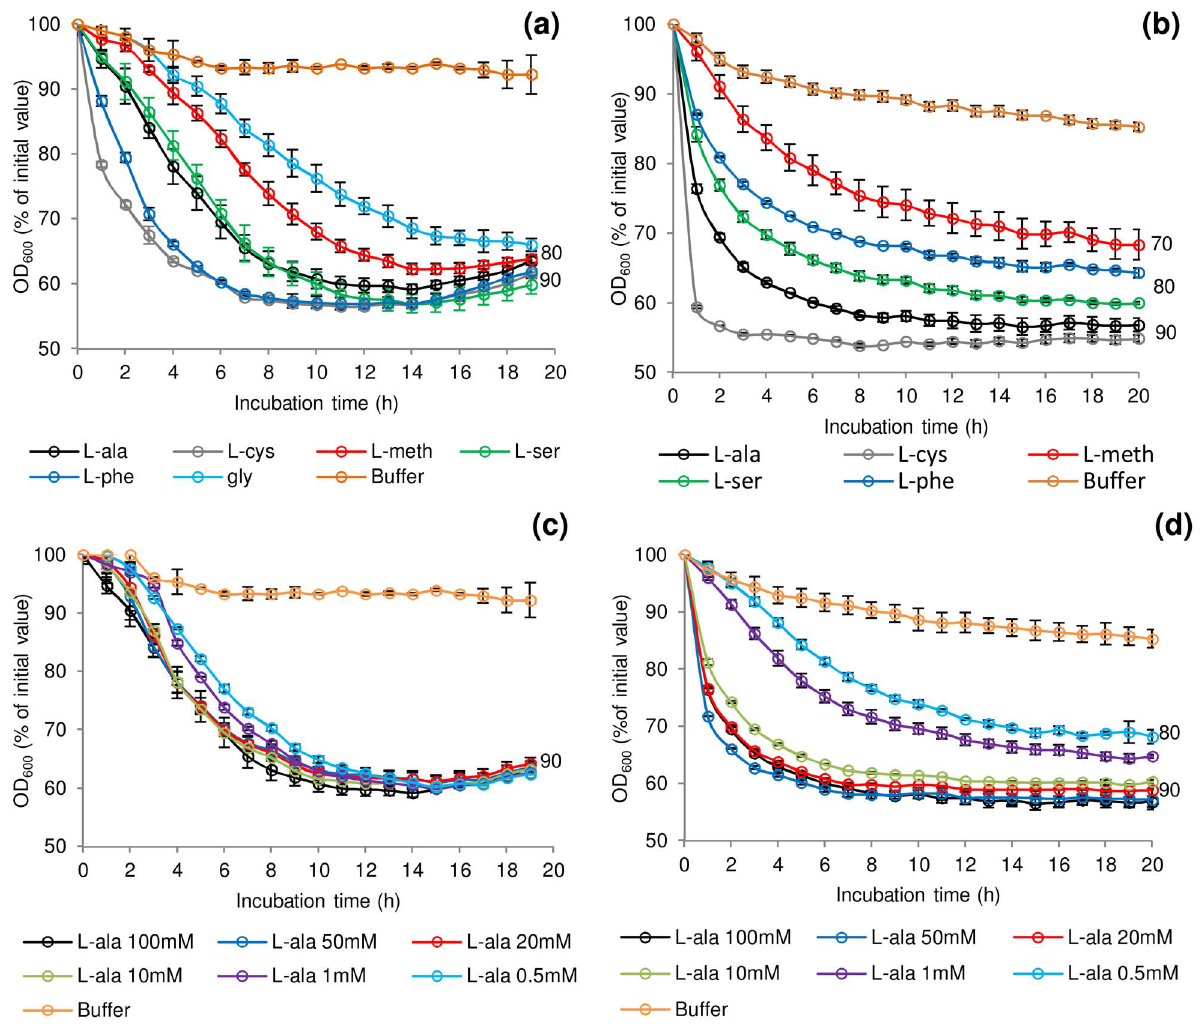
Figure 1. Rate of C.botulinum and C.sporogenes spore germination in the presence of selected amino acids. Effect of L-alanine, L- cysteine, L-methionine, L-serine, L-phenylalanine and glycine ( C. botulinum only) at 100 mM on germination of (a) C. botulinum ATCC3502 and (b) C. sporogenes ATCC15579. The effect of increasing L-alanine concentrations (0.5 mM–100 mM) on germination was also tested on (c) C. botulinum ATCC3502 and (d) C. sporogenes ATCC15579. Tests were conducted in 20 mM Tris buffer, pH 7.4, L-lactate (50 mM) and NaHCO 3 (50 mM) at 30 u C. Buffer only controls contained 20 mM Tris, pH 7.4, L-lactate (50 mM) and NaHCO 3 (50 mM). Data labels (right) refer to percentage germination observed by phase contrast microscopy at the end of the experiment. Error bars represent the standard deviation of 3 independent